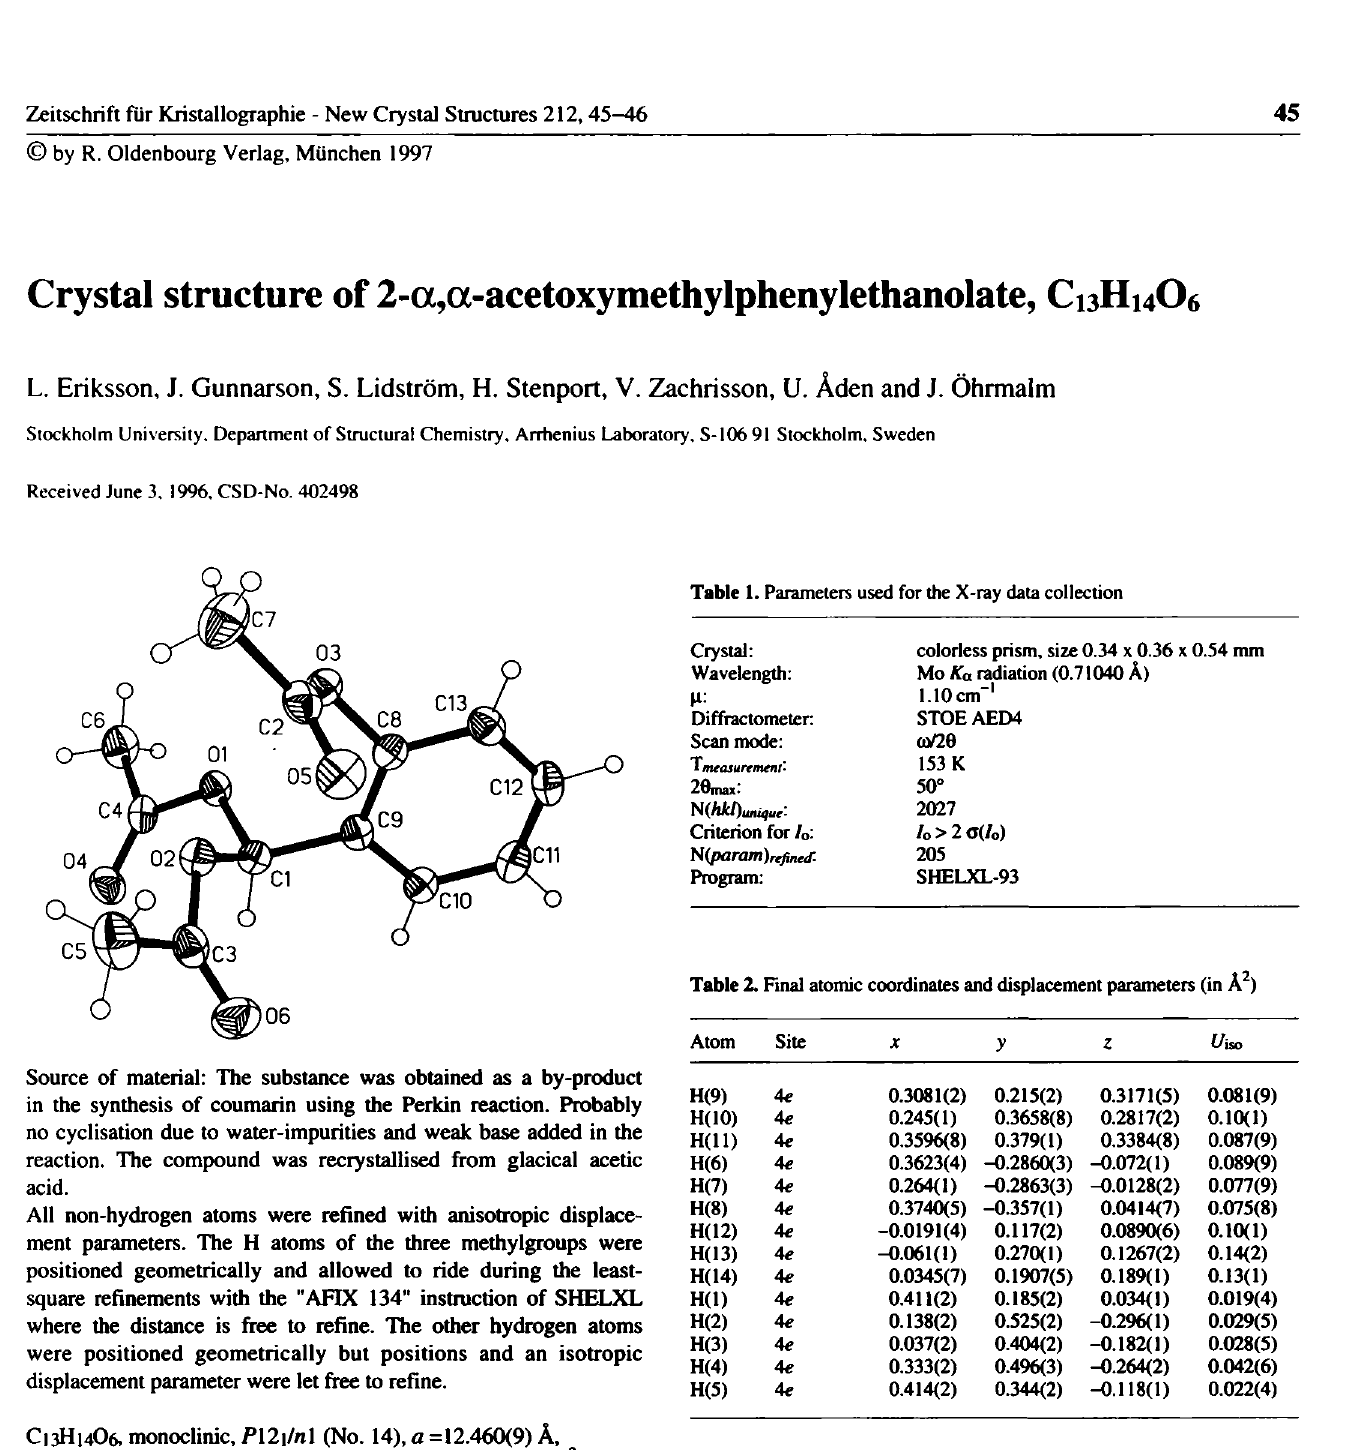
Table 3. Final atomic coordinates and displacement parameters (in À 2 )